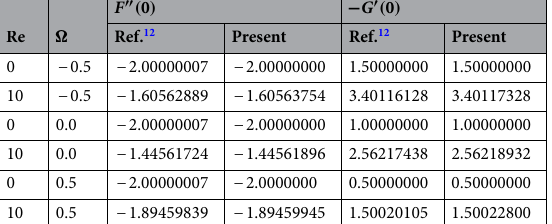
Table 2. The comparison of − G ′ ( 0 ) , − F ′′ ( 0 ) and (cid:31) for different values of Re and (cid:31) in case, when S S 1 = 0.5, 2 = 0.0.